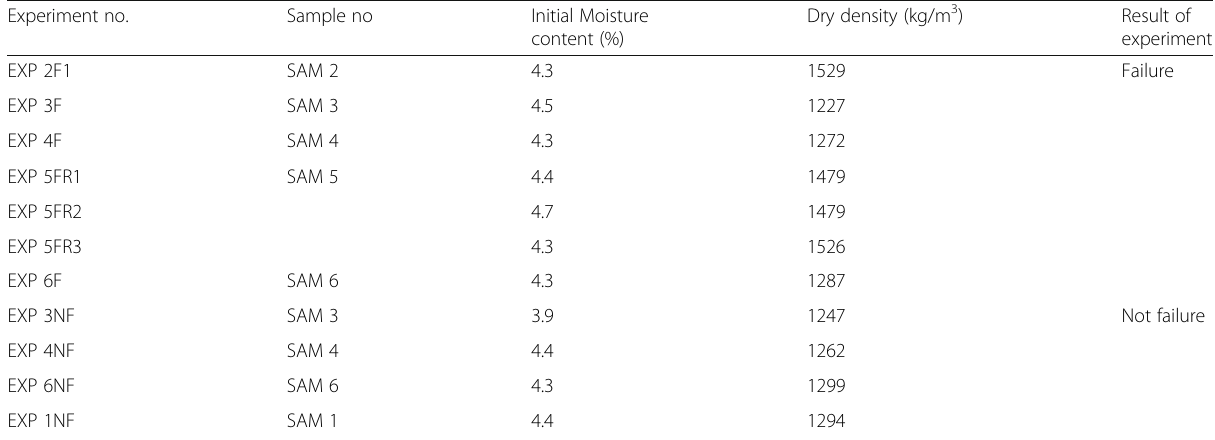
Table 3 Initial state of samples and result of experiments Experiment